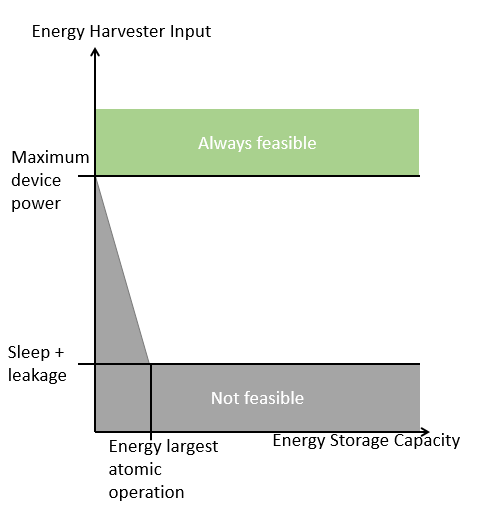
Figure 13. An energy harvesting node can never be feasible when its input is lower than the lowest current consumption of the device and the leakage in the device. In contrary, it will always be feasible when the harvested power exceeds the device maximum energy consumption.